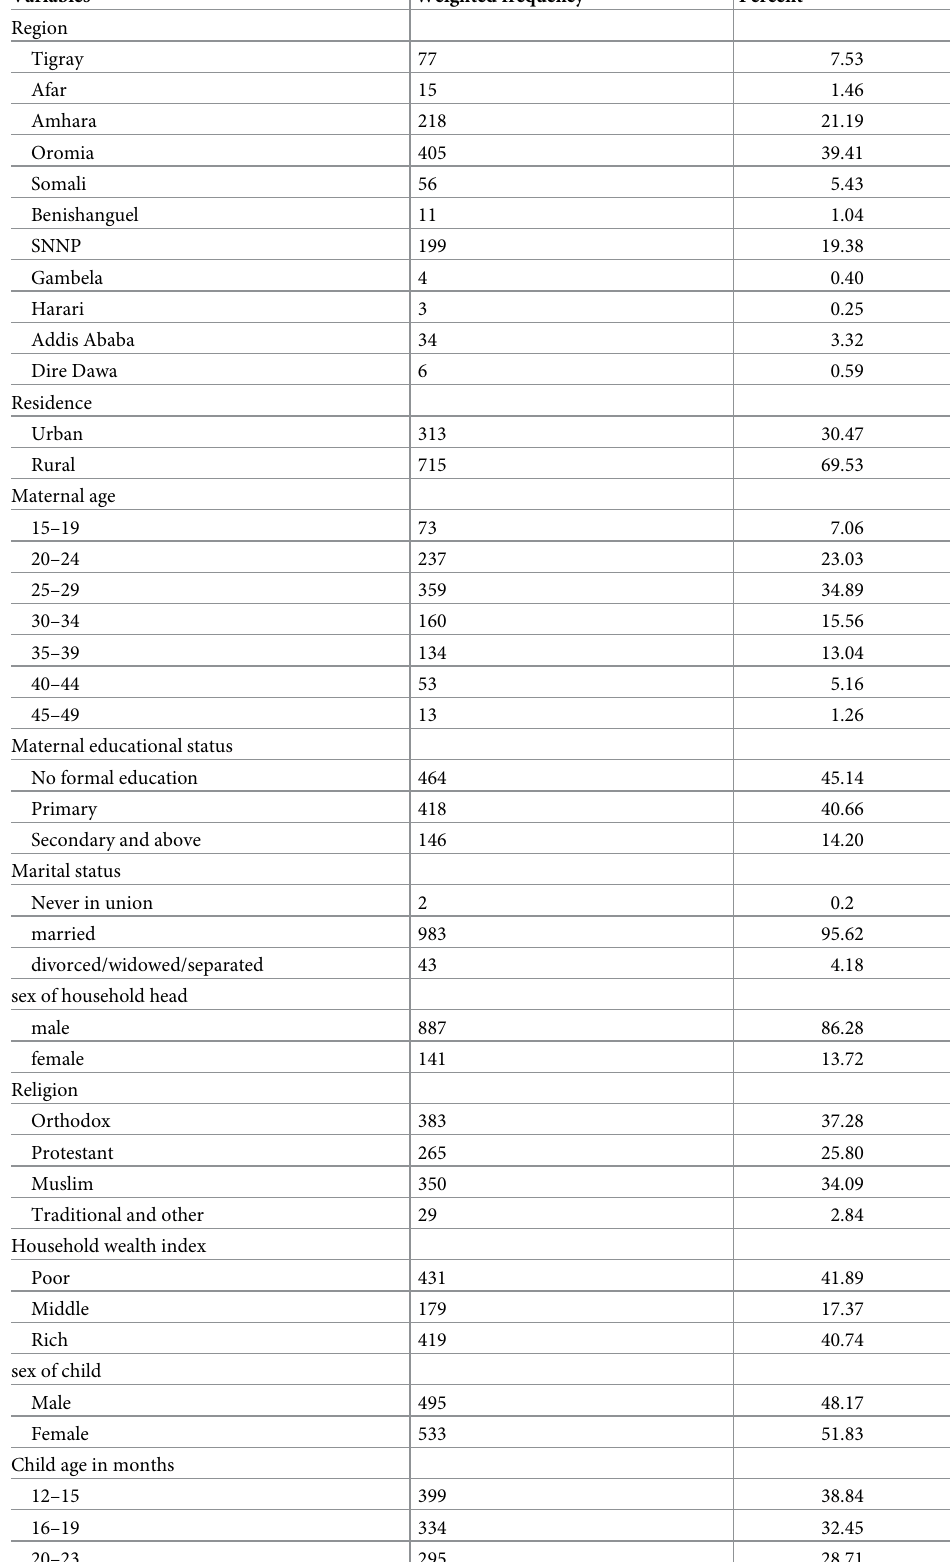
Table 1. Sociodemographic and socioeconomics characteristics of the study